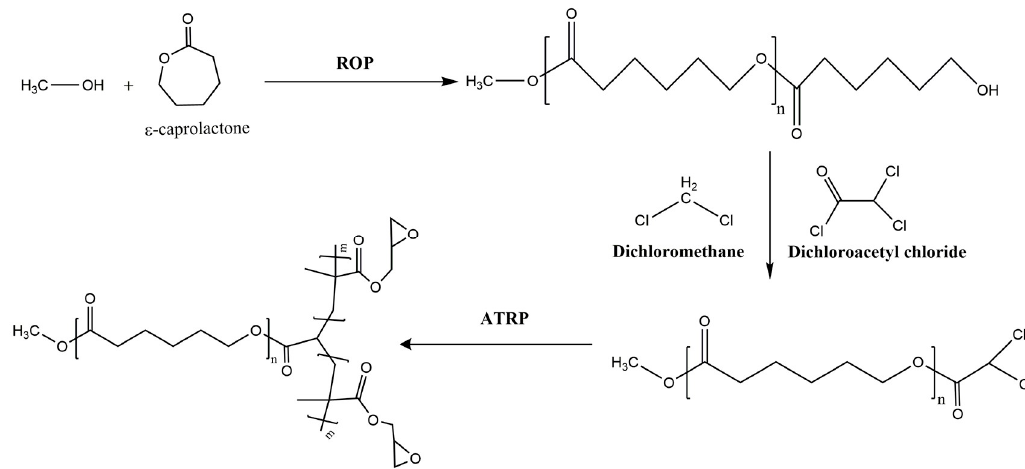
Figure 7. Synthesis of multiarms (PCL-PGMA) through the ROP and